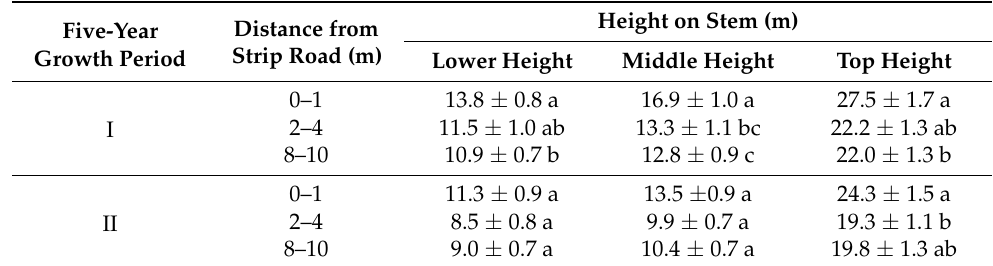
Table 2. Five-year growth in diameter (mm; mean values ± SE) at lower, middle and top height zones related to the distance from the strip road in the 2.5 m variant.